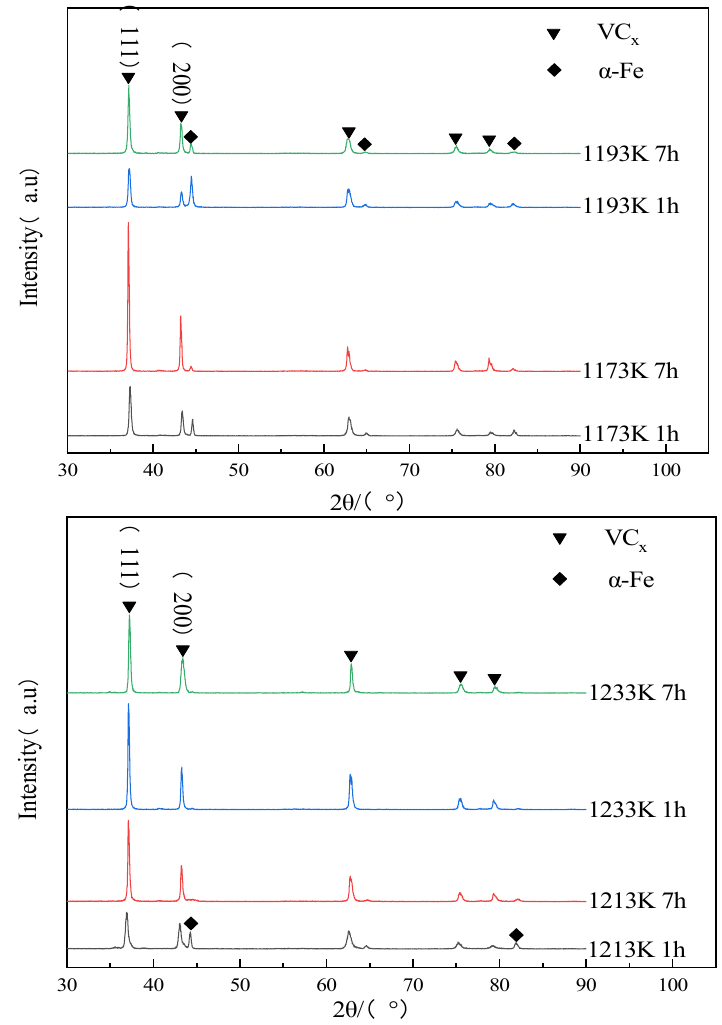
Figure 8. X-ray diffraction spectrum of vanadiumizing layer prepared at different heating temperatures for 1 and 7 h.